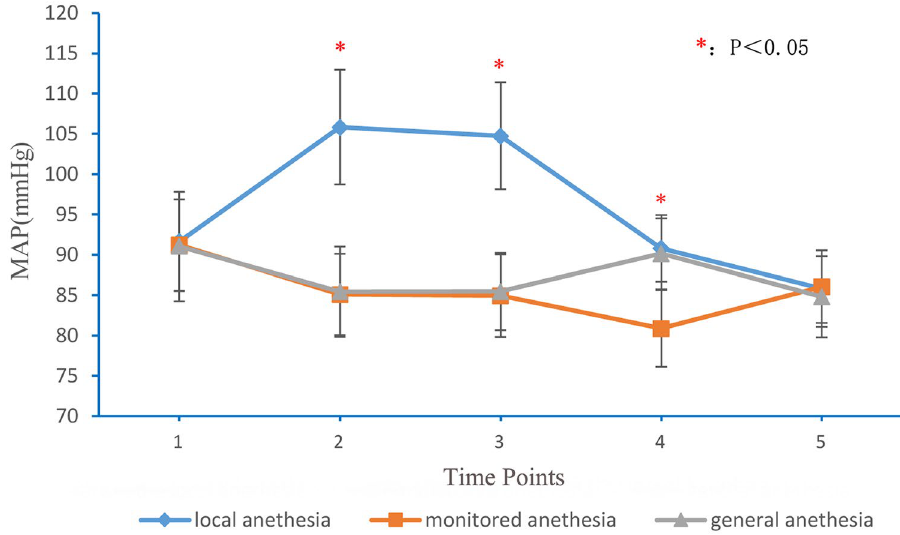
Figure 1. MAP at different time points for local anesthesia, monitored anesthesia and general anesthesia groups. MAP mean arterial pressure. 1: 1 h before anesthesia; 2: puncture of trocar into vertebral body; 3: injection of bone cement into vertebral body; 4: 2 h after operation; 5: 1 day after